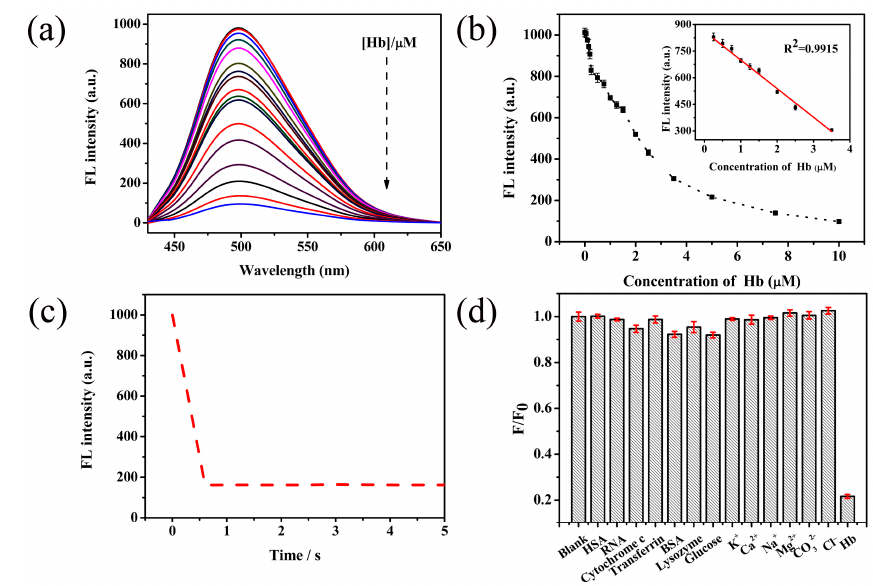
Figure 6. ( a ) Fluorescence response of the Pd NCs in the presence of various concentration of hemoglobin (0.05, 0.1, 0.15, 0.2, 0.25, 0.5, 0.75, 1, 1.25, 1.5, 2, 2.5, 3.5, 5, 7.5, and 10 μ M); ( b ) Plots showing relationship between fluorescence intensity and hemoglobin concentration. Inset shows the hemoglobin linear detection range of 0.25–3.5 μ M; ( c ) Response time of Pd NCs introducing 5 μ M hemoglobin; ( d ) Selective experiments of Pd NCs for competitive molecules (5 μ M).